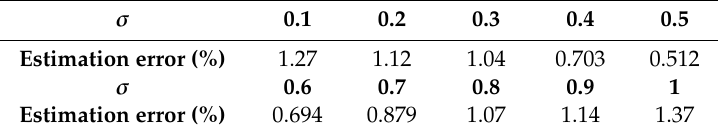
Table 6. Estimation error under di ff erent kernel widths.